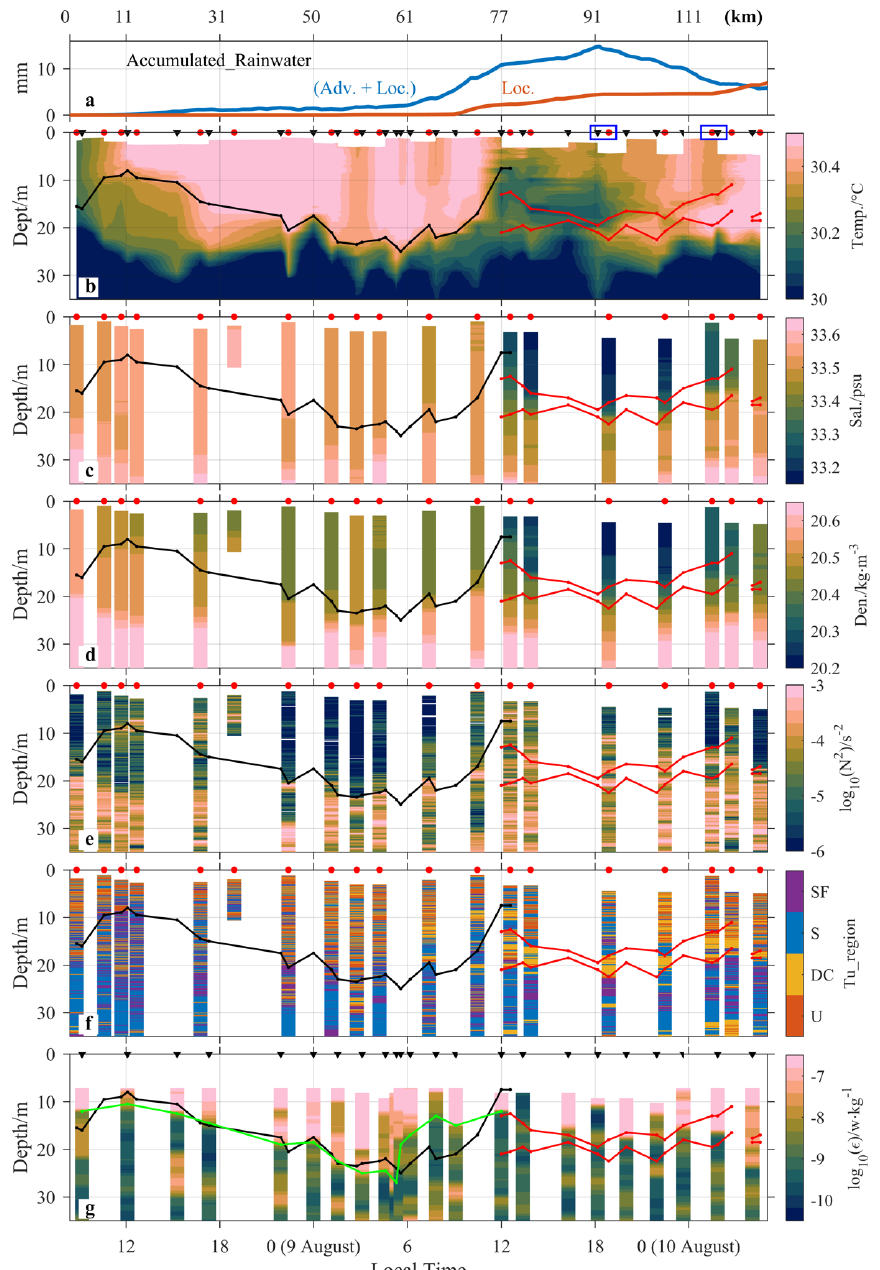
Figure 6. ( a ) R PTS·ship (blue solid lines) and R local (red solid lines). Distance coordinates were added according to the R/V track in space. ( b – g ) Vertical profiles during the cruise observations. Black triangles indicate VMP profiles. Red dots indicate CTD profiles. ( b ) Temperature. ( c ) Salinity. ( d ) Potential density anomaly. ( e ) Squared buoyancy frequency ( N 2 ). ( f ) Double-diffusive stability based on the Turner angle. ( g ) TKE dissipation rate. Red lines in ( b – g ) indicate the depth range of the temperature inversion layer. Black lines in ( b – g ) indicate the base of the diurnal mixed layer according to the 0.2 °C temperature criteria. Green lines in ( g ) indicate the base of the active mixing layer according to the 10 − 9 W/kg background dissipation rate. Blue boxes in ( b ) indicate the typical profiles shown in Figure 7 .